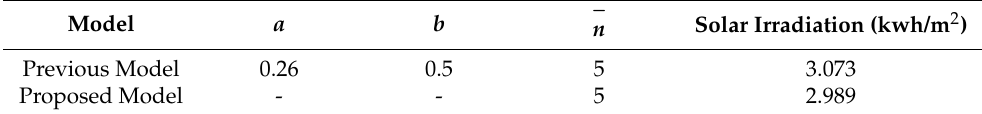
Table 1. Comparison between different models to estimate solar radiation.